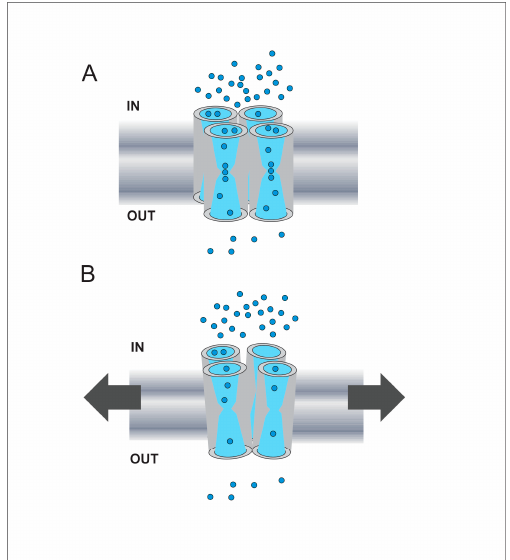
Figure 3. Schematic representation of AQP regulation mediated by membrane tension increments. ( A ) Illustration of a tetramer in a membrane subjected to basal tension. The applied osmotic gradient is represented by the different amount of water molecules (light blue circles) between extracellular and intracellular compartments (OUT and IN, respectively). The water pathway is schematically represented in each monomer. Since the membrane is not subjected to extra tension at the beginning of the osmotic response, the four monomers are not subjected to extra strain and the water permeability is high. ( B ) The development of the osmotic response produces increments of cell volume and pressure, and hence the increase of membrane tension [38,135], represented by arrows. This could produce slight distortions on the tetramer as well as slight distortions on each monomer. In mechanosensitive aquaporins we propose that these changes affect the distance between water molecules and the pore-lining residues that participate in H-bonds, e.g., at the cytoplasmic entrance to the single-file region [140]. Consequently, the probability for a water molecule to form H-bonds with pore-lining residues would be lower, producing a decrease of the unitary water permeability [54]. These events that occur in each monomer could be affected by the interactions with its neighbors, what could produce a cooperative effect for P f decrease [38]. This scheme is inspired on the cooperative mechanism proposed by Hill et al. and used to formulate the osmosensor hypothesis